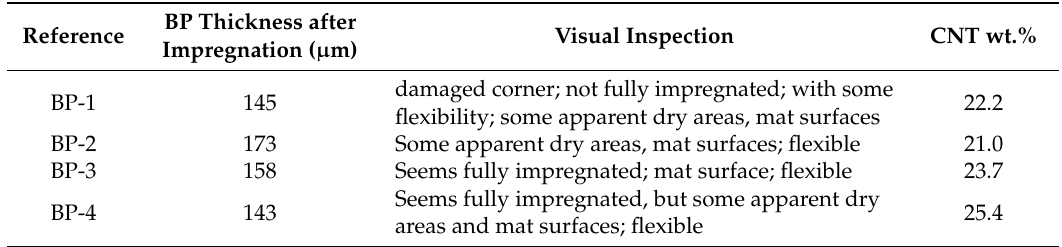
Table 12. Properties of manufactured CNT buckypaper samples.